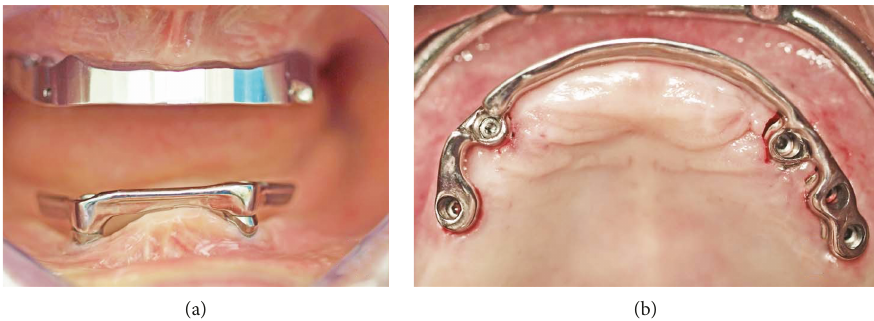
Figure 10: Bars mounted onto the implants: (a) front view and (b) palatal view.